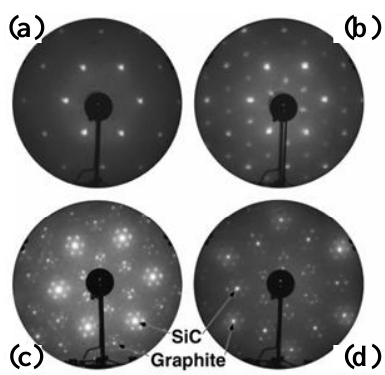
Figure 4. LEED patterns in different temperatures and times (Reproduced from [21] with permission; Copyright 2004 American Chemical Society). ( a ) 1050 °C, 10 min; ( b ) 1100 °C, 3 min; ( c ) 1250 °C, 20 min; ( d ) 1400 °C, 8 min.